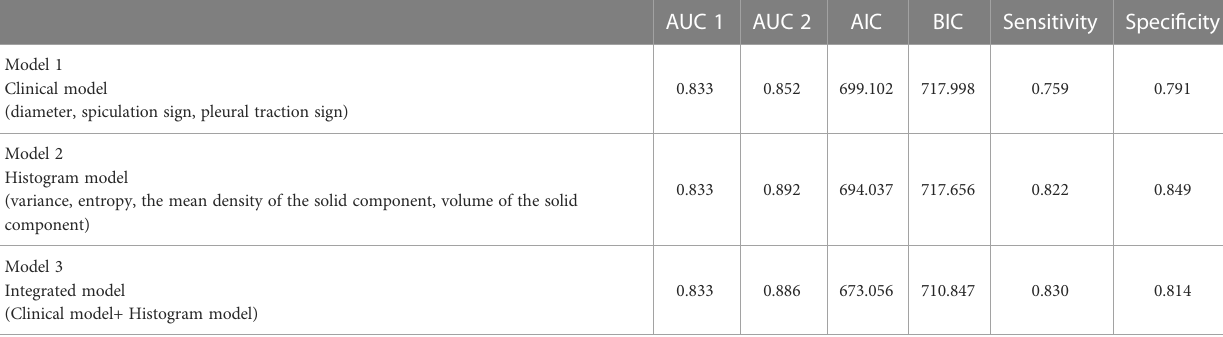
TABLE 4 Diagnostic performance of three predictive models for predicting invasive adenocarcinoma lesions.